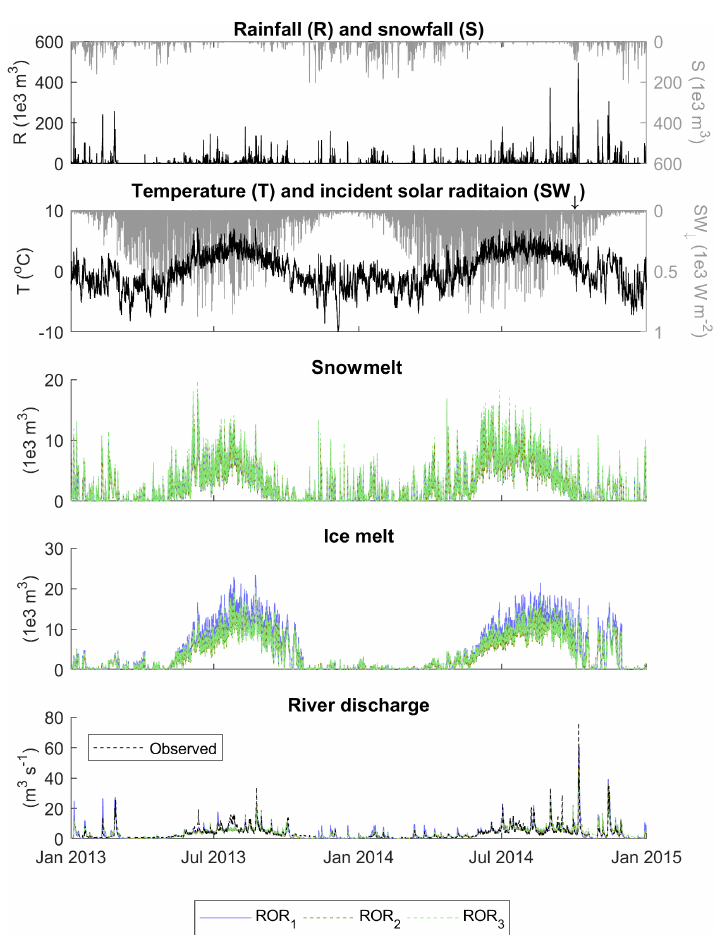
Figure D2. Time series of driving precipitation, temperature and incident solar radiation data and simulated snowmelt, ice melt and river discharge using the ROR 1 , ROR 2 and ROR 3 run-off-routing model structures in conjunction with the simplest TIM 1 melt model structure. Note that the proportion of rainfall and snowfall is an output from the GHM, which is approximately equal across the different configurations. Also note that ice melt includes melt of bare ice and